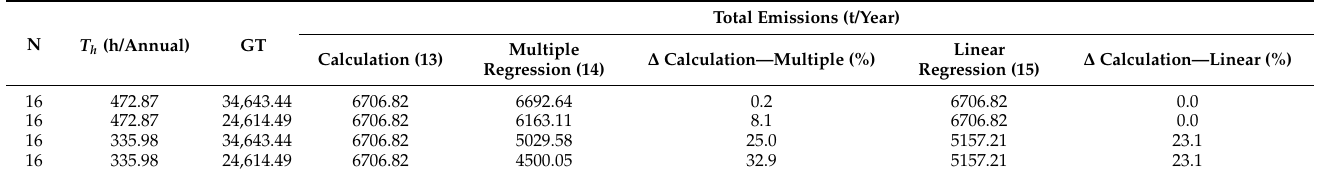
Table 18. Results comparison of the total emissions estimation from the 16 ships ( N ) applying regression according to average value and higher frequency of GT and T h